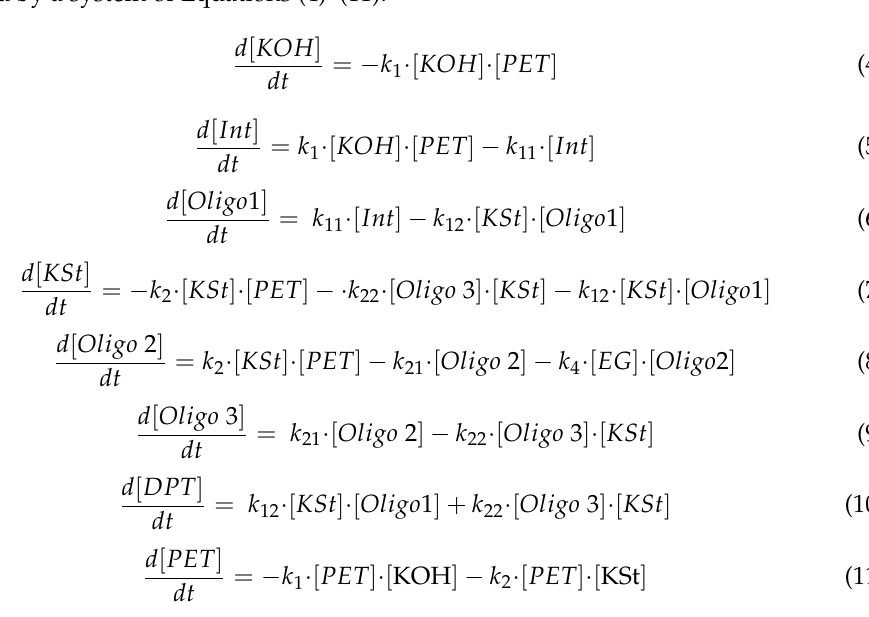
Figure 9. General scheme of the PET saponification process.